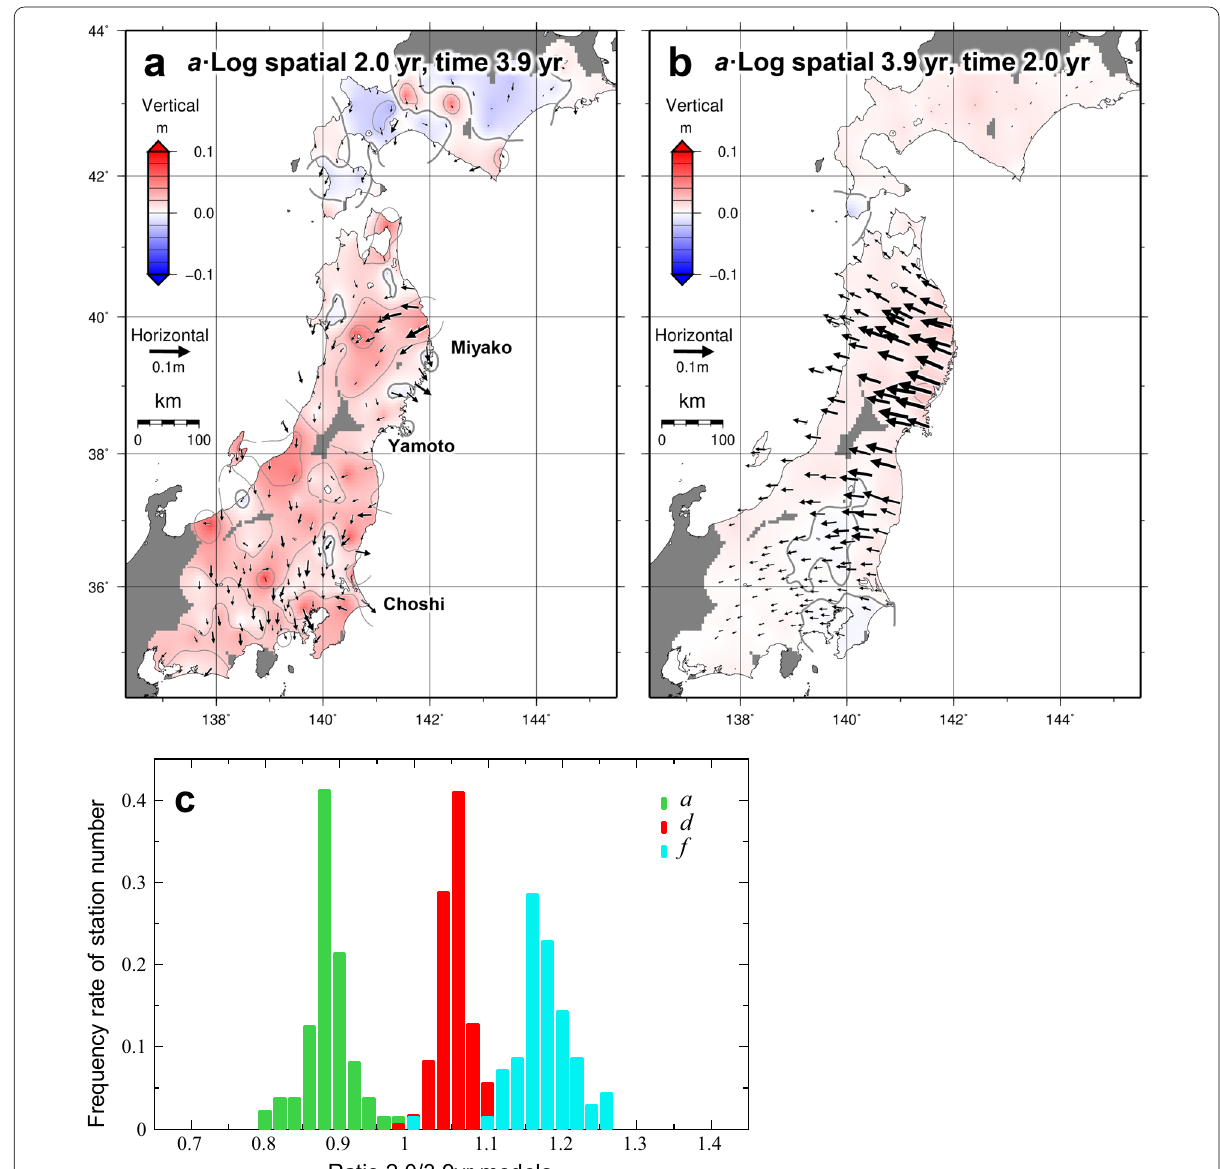
Fig. 10 Comparison between the predicted values with different fitting periods. a Spatial distribution of the residuals of the short-period logarithmic term in Eq. (1) for the spatial functions with the fitting period of 2.0 years and the time constants of the 3.9-year model [S2.0T3.9] (green line in Fig. 9). As a reference value, we use the 3.9-year model (the spatial functions with the fitting period of 3.9 years and the time constants of the 3.9-year model [S3.9T3.9]). b Same as a but for the spatial functions with the fitting period of 3.9 years and the time constants of the 2.0-year model [S3.9T2.0] (red line in Fig. 9). c Histogram of the ratio of the spatial function for the different time constants of the 2.0-year model [S3.9T2.0] to that of the 3.9-year model [S3.9T3.9]. Green color depicts the short-period logarithmic term ( a ), red color indicates the long-period logarithmic term ( d ), and blue color represents the exponential term ( f ) in Eq. (1) (see Additional file 1: Fig. S6 for more